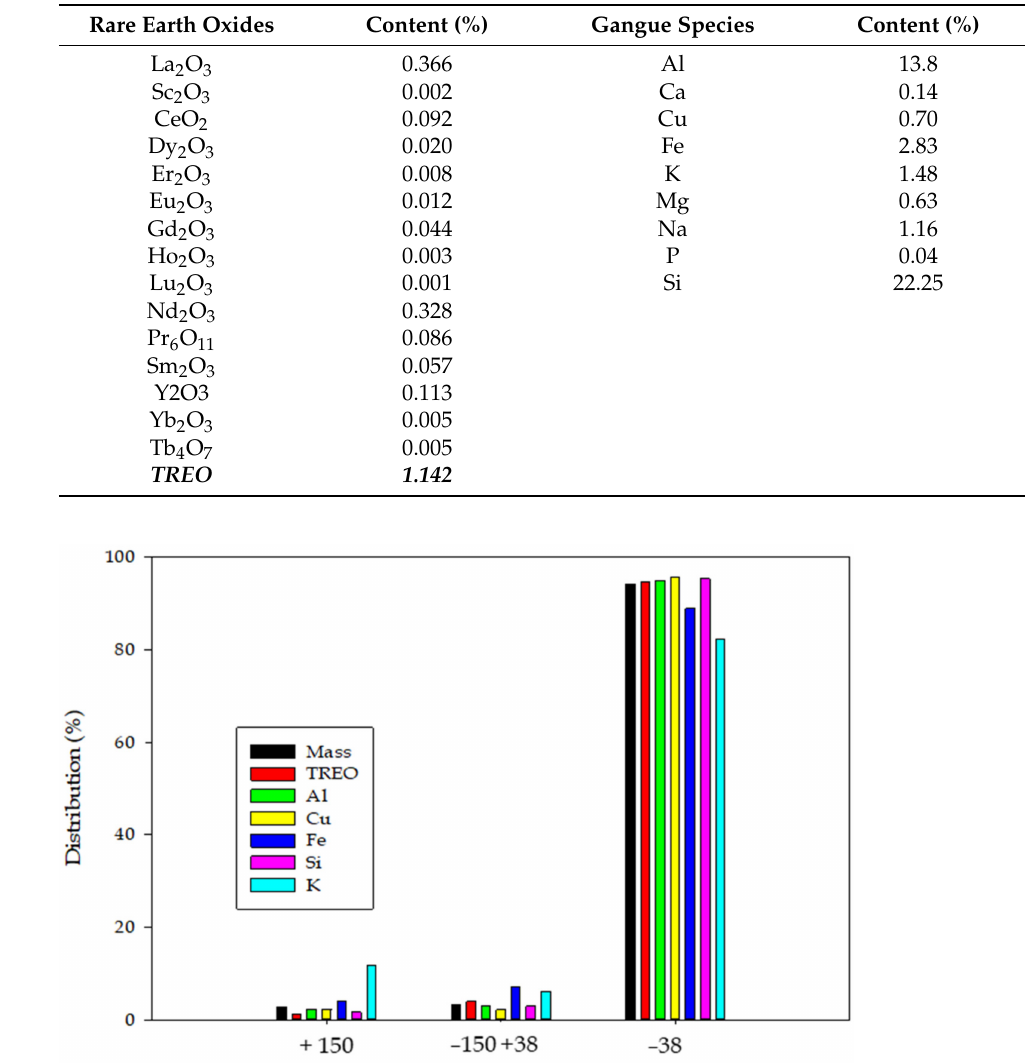
Table 1. Summary of results obtained from ICP-MS analysis.